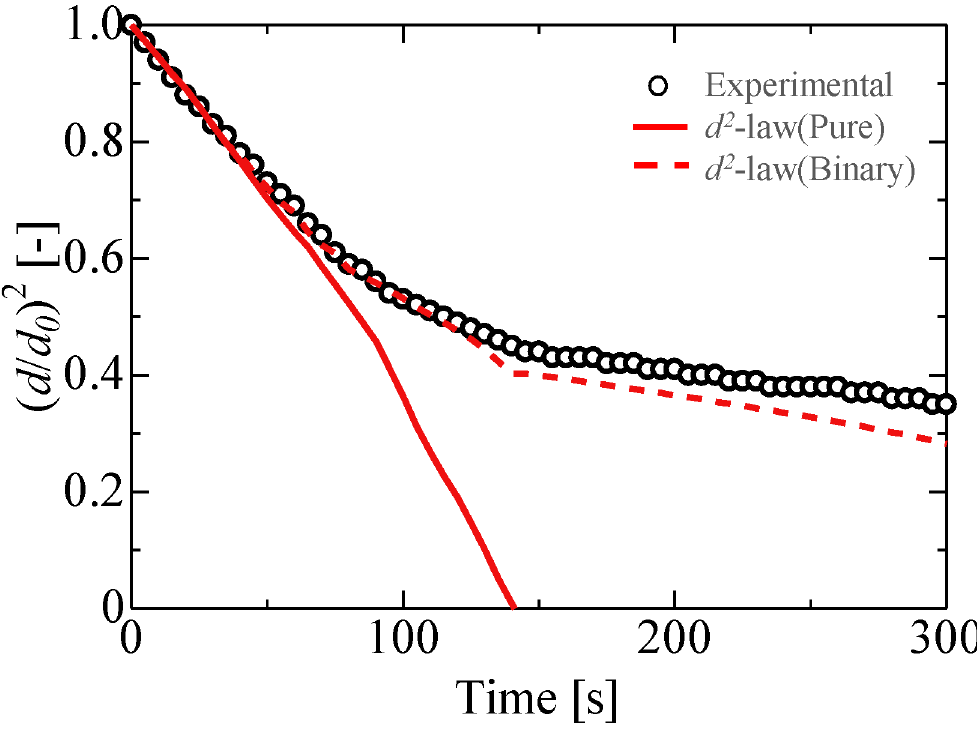
Fig 12. Re-evaluation of evaporation process for ethanol droplets. d